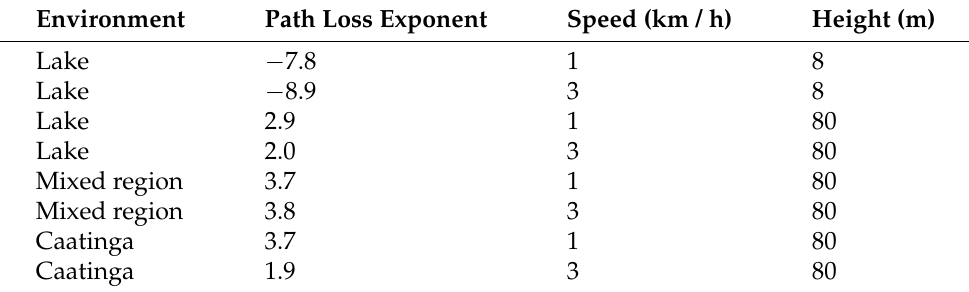
Table 6. Path loss exponent for different environments.